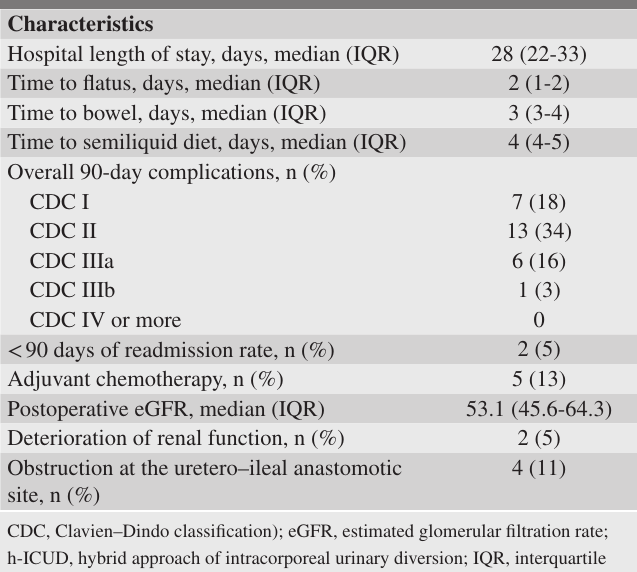
Table 3. Postoperative Outcomes of 38 Patients who Underwent RARC with h-ICUD